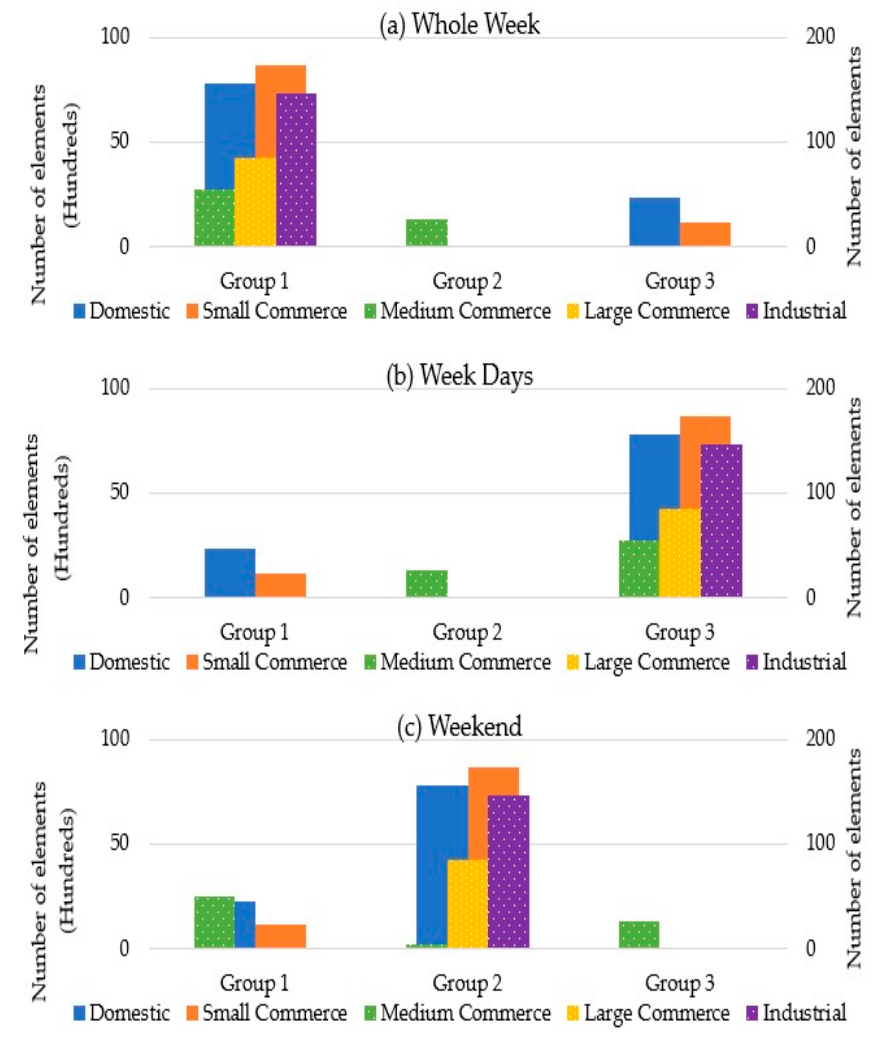
Figure 5. k-means method. ( a ) Results for the whole week scenario; ( b ) results for the week days scenario; ( c ) results for the weekend scenario.